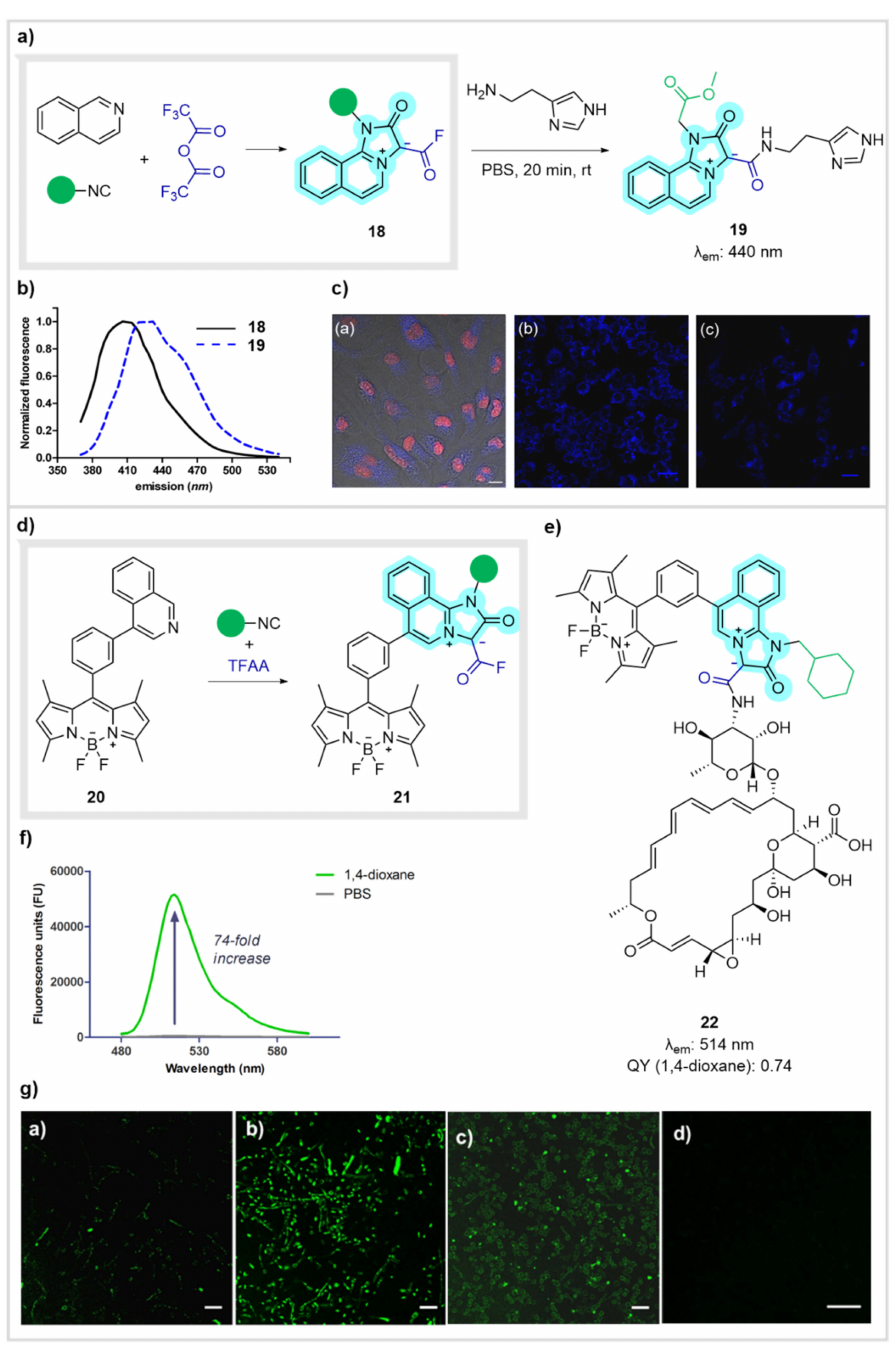
Figure 8. ( a ) MCR access to probe 18 for imaging of histamine in live cells. ( b ) Normalized fluo- rescence of probe 18 (black) and histamine adduct 19 (blue). ( c ) Microscopy images of: ( a ) RBL- 2H3 basophils upon incubation of probe 18 with DRAQ5 as nuclear counterstaining; ( b ) RAW 264.7 macrophages after incubation with Histamine blue and upon histamine uptake and ( c ) after treatment with thapsigargin. Sections (b,c) from ref [48] (N. Kielland et al., Chem. Commun . 2012 , 48 , 7401) reproduced with permission form the Royal Society of Chemistry. ( d ) MCR to the BODIPY dipolar acid fluoride 21 . ( e ) Structure of probe 22 , from conjugation of 21 with natamycin. ( f ) Fluores- cent properties of probe 22 in 1,4-dioxane and in PBS. ( g ) Fluorescence images of fungal and bacterial cells upon incubation with 20 : ( a ) F. solani , ( b ) F. oxysporum , ( c ) A. flavus and ( d ) P. Aeruginosa . Scale bar: 20 µ m. Sections ( f , g ) from ref [50] (M. Sintes et al. Bioconjug. Chem . 2016 , 27 , 1340) reproduced with permission. Copyright 2016